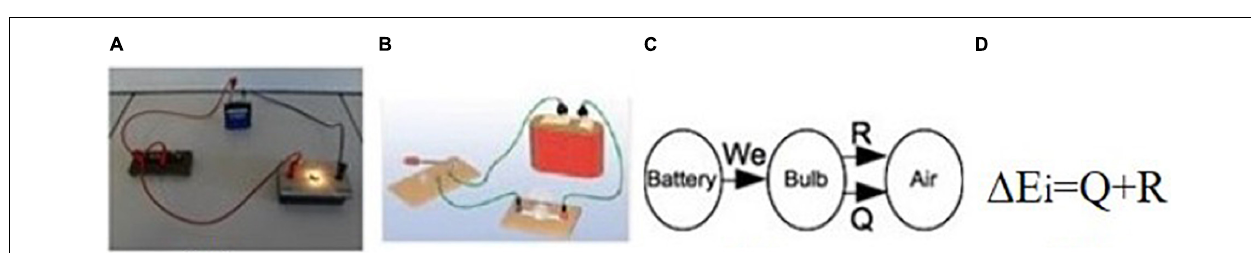
FIGURE 4 | (A–D) Naturalistic and abstractive inscriptions.